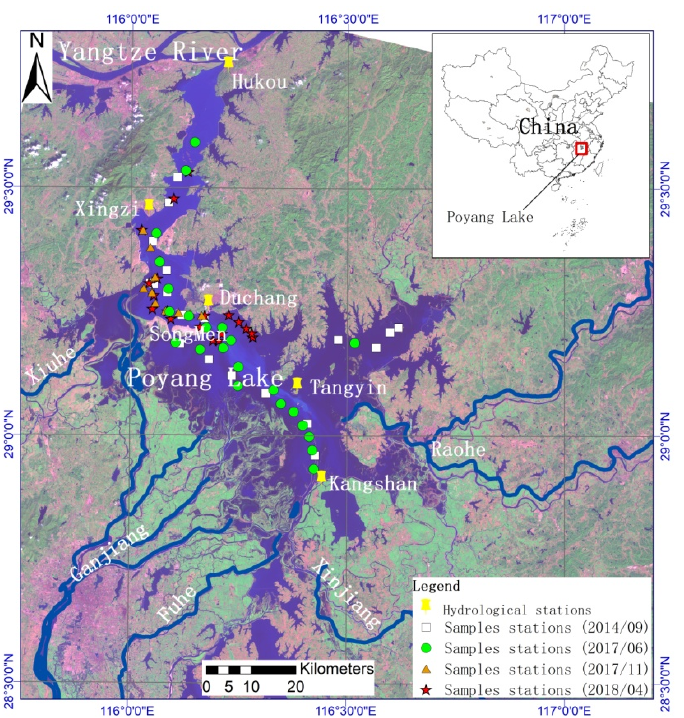
Figure 1. The location of Poyang Lake, the exits of the five rivers, hydrological stations and sam- pling stations.